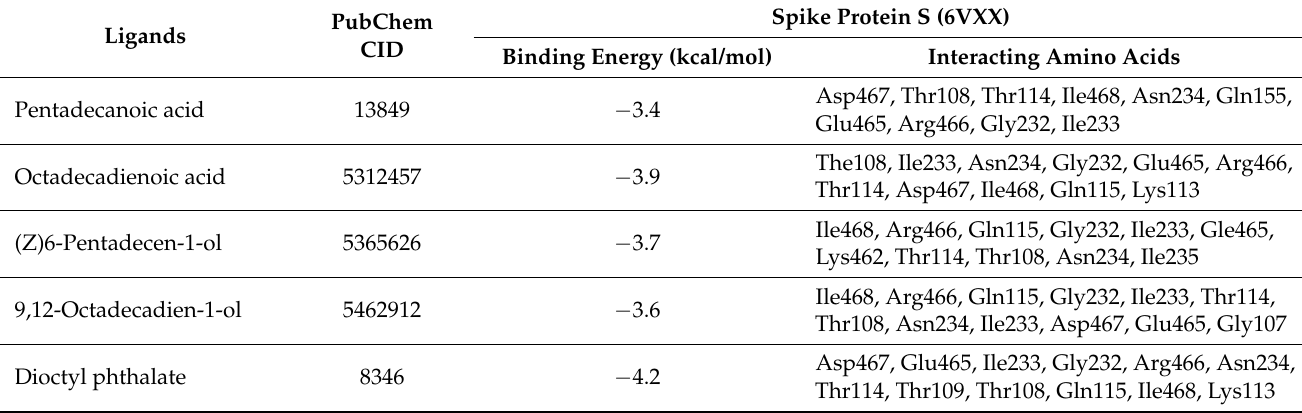
Table 1. Details of molecular docking study; the ligands, binding energy, and interacting amino acids interacting with